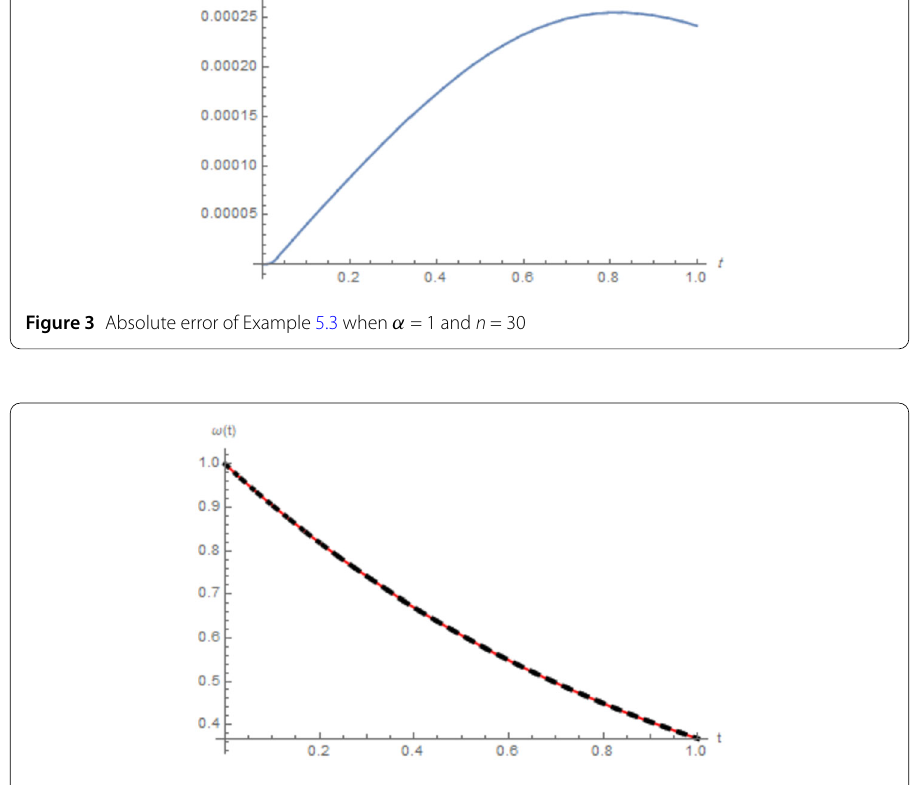
Figure 4 Exact ω ( t ) (red) and RK solution ω 30 ( t ) (dashed) for Example 5.3 at α = 1